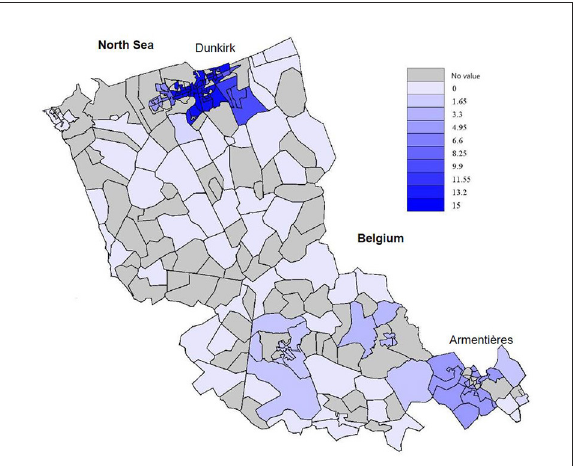
FIGURE2 Density of gynecology care facilities within 5km of a GP surgery on the territory of the CPAM of